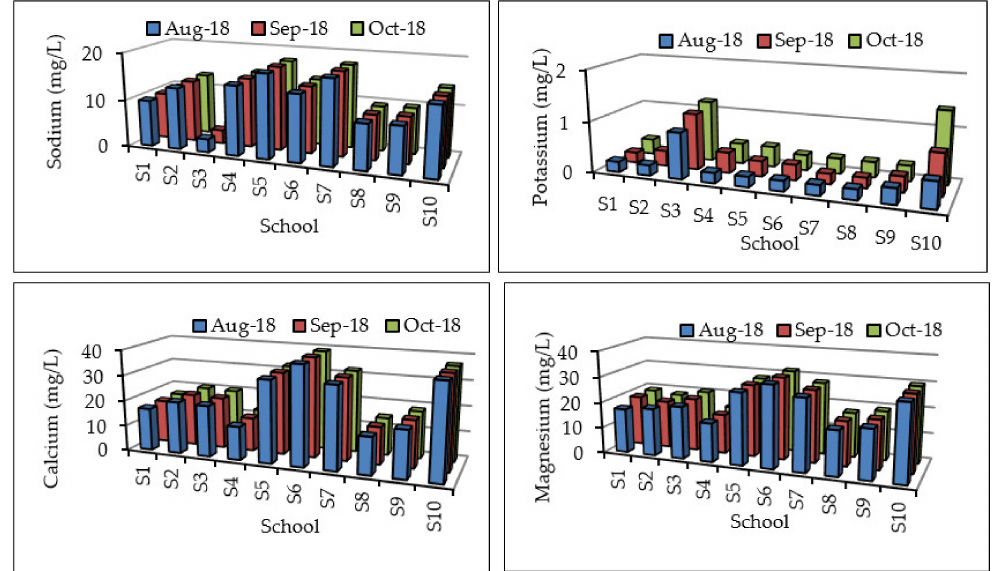
Figure 4. Sodium, calcium, potassium, and magnesium concentrations (mg / L) in groundwater